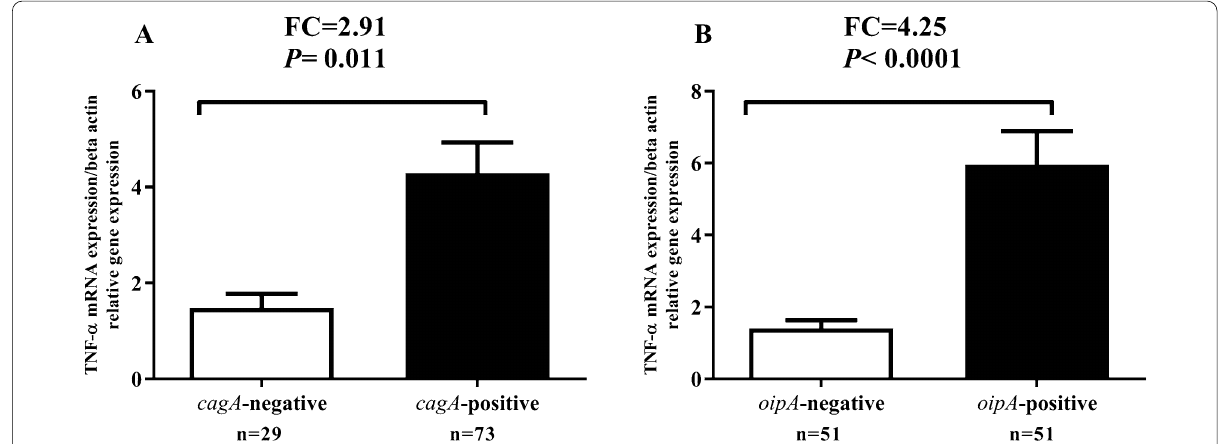
Fig. 3 Comparison of TNF‑α mRNA expression in patients infected with or without the cagA and oipA virulence factors. TNF‑α expression was significantly increased in patients infected with cagA ‑positive in comparison with patients infected with cagA ‑negative. Also, TNF‑α expression was significantly increased in patients infected with oipA ‑positive in comparison with patients infected with oipA ‑negative . P < 0 .05 was considered statistically significant by independent‑samples t‑test (N number and FC fold change) = =